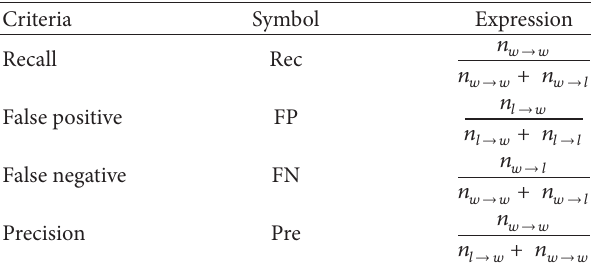
Table 1: Verification criteria. Table 2: Number of training and testing set used in the